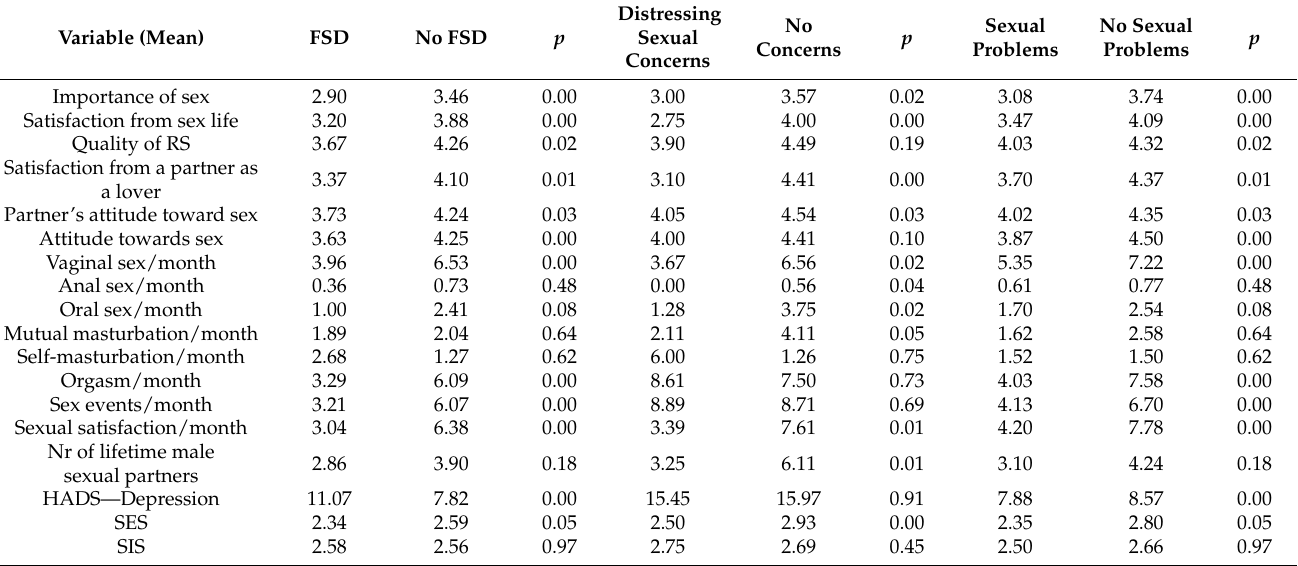
Figure 2. Changes in sexual function according to respondents’ opinion. The between-group comparison (FSD vs. no FSD, sexual problems vs. no sexual prob- lems, and distressing sexual concerns vs. no concerns) showed some statistical differences, as presented in Table 3. Additionally, the analysis of the qualitative variable revealed that the prevalence of FSD was statistically higher in women with primary education—45.4% had FSD compared with 12.5% and 20.0% in the secondary and higher education groups ( p = 0.04). FSD was also more frequent in those not taking MHT (23.1% vs. 9.7%, p = 0.02). Distressing sexual concerns were more frequent in Roman Catholics compared with the followers of other religions and atheists (65% vs. 25% vs. 10%, respectively, p = 0.02). Finally, the prevalence of sexual problems (CSFQ scores) was lower in those consuming alcohol compared with non-consumers (30% vs. 61.5%, p = 0.02) and less frequent in those watching erotic videos (44.6% vs. 64.1%, p = 0.01). Table 3. Comparison between different group of studied women according to the presence of sexual dysfunctions, concerns, and